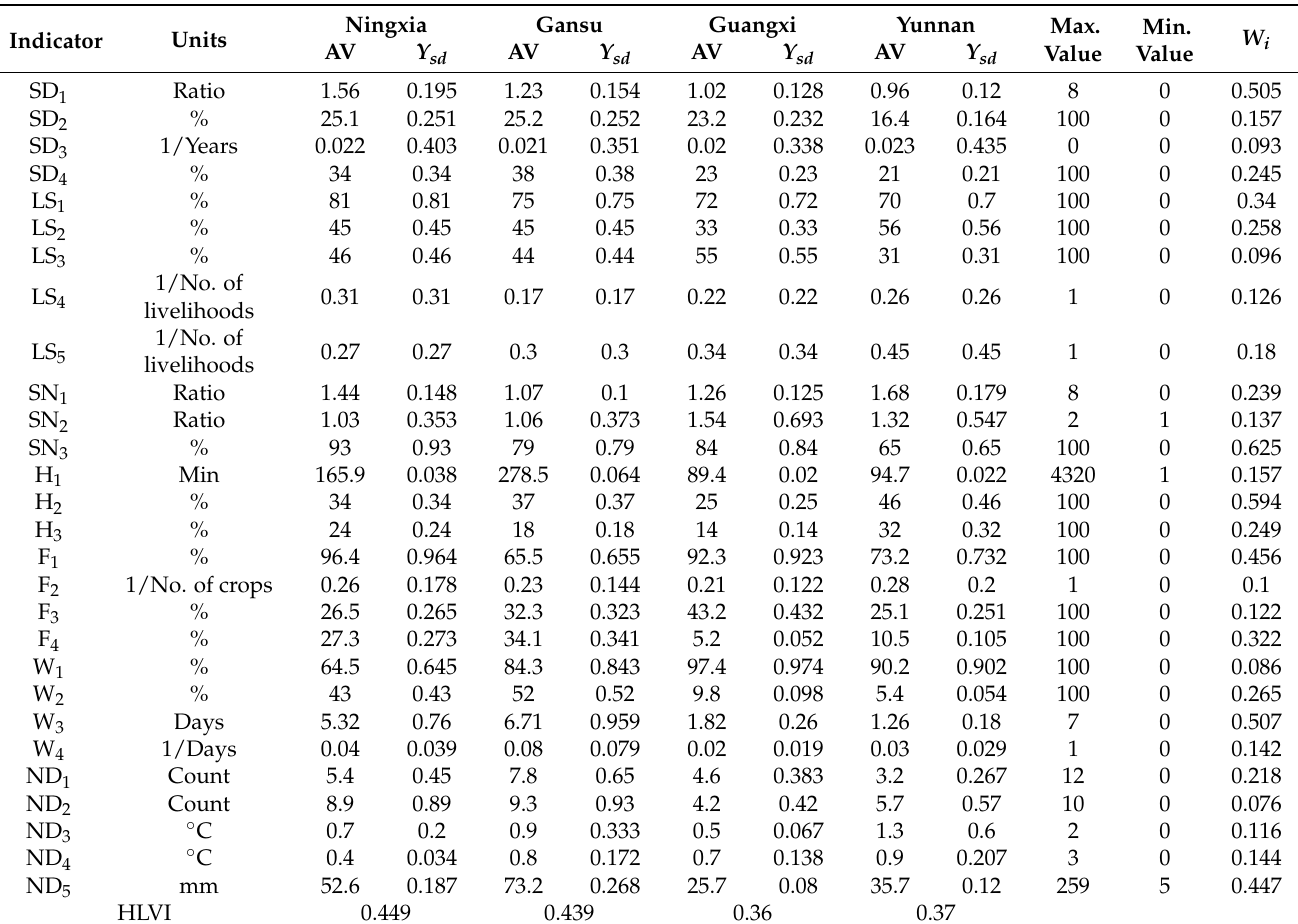
Table 4. Overall results of indicators in HLVI for Ningxia, Gansu, Guangxi, and Yunnan